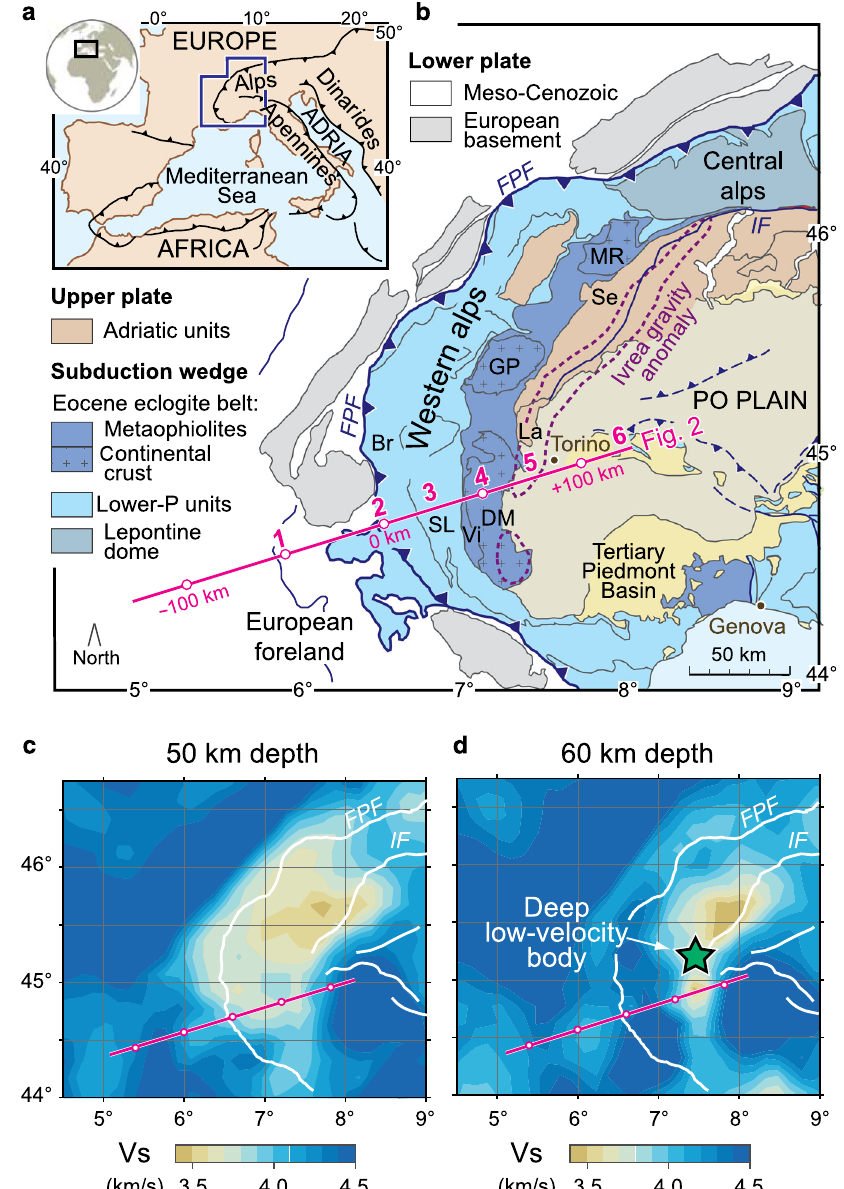
Fig. 1 Geologic setting and depth slices of Vs. a Tectonic sketch map of the Adria – Europe plate boundary zone. b Geological sketch map of the western Alpine region (modi fi ed from Malusà et al. 45 ). The magenta line indicates the location of the cross section of Fig. 2a. Numbers 1 – 6 indicate the sites of the depth-velocity pro fi les illustrated in Fig. 2b. The purple line indicates the gravity anomaly of the Ivrea body (0 mGal isoline). Acronyms: Br, Briançonnais; DM, Dora-Maira; FPF, Frontal Pennine Fault; GP, Gran Paradiso; IF, Insubric Fault; La, Lanzo; MR, Monte Rosa; Se, Sesia-Lanzo; SL, Schistes lustrés; Vi, Viso. c , d Vs structure at different depths (50 km and 60 km) after TransD inversion. The green star marks the deep – low-velocity body (yellow to wheat